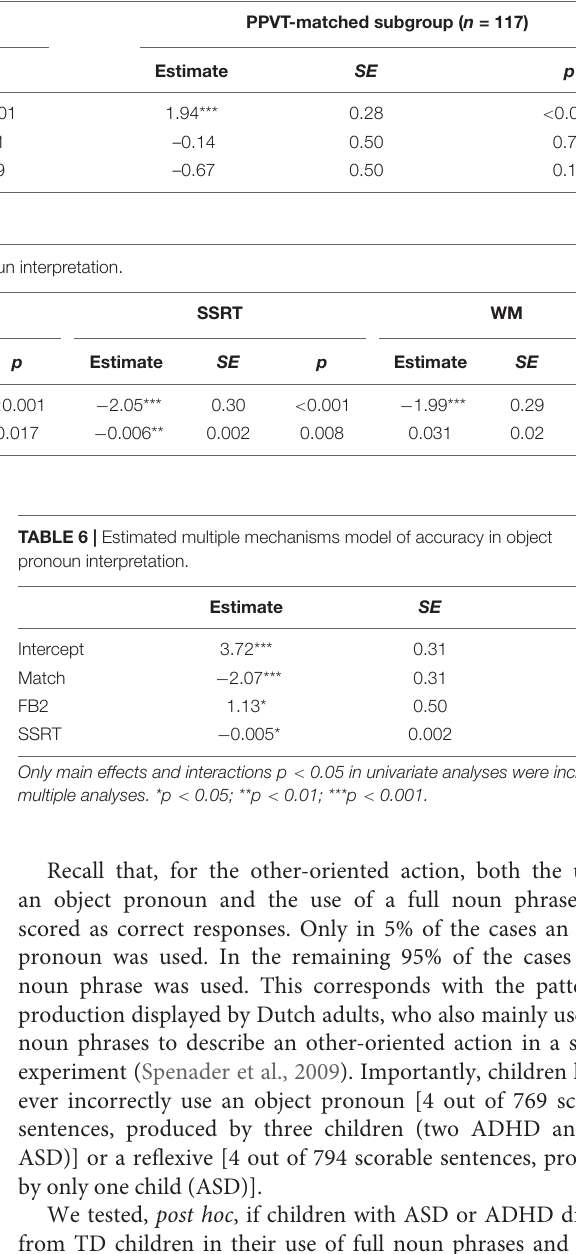
TABLE 4 | Estimated effects for Clinical group and Match on accuracy in object pronoun interpretation for the IQ-matched subgroup and for the PPVT-matched subgroup.